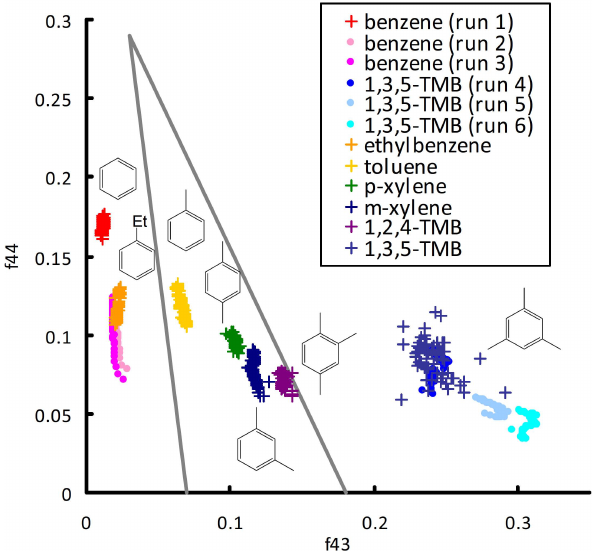
Fig. 4. Triangle plot of SOA formed from the photooxidation of aromatic hydrocarbons in the presence of NO x ; data of benzene and 1,3,5-TMB shown with a run number are present results; other data of six aromatic hydrocarbons are taken from Sato et al. (2010); cross symbol data (+) are obtained at the initial NO x concentrations of ∼